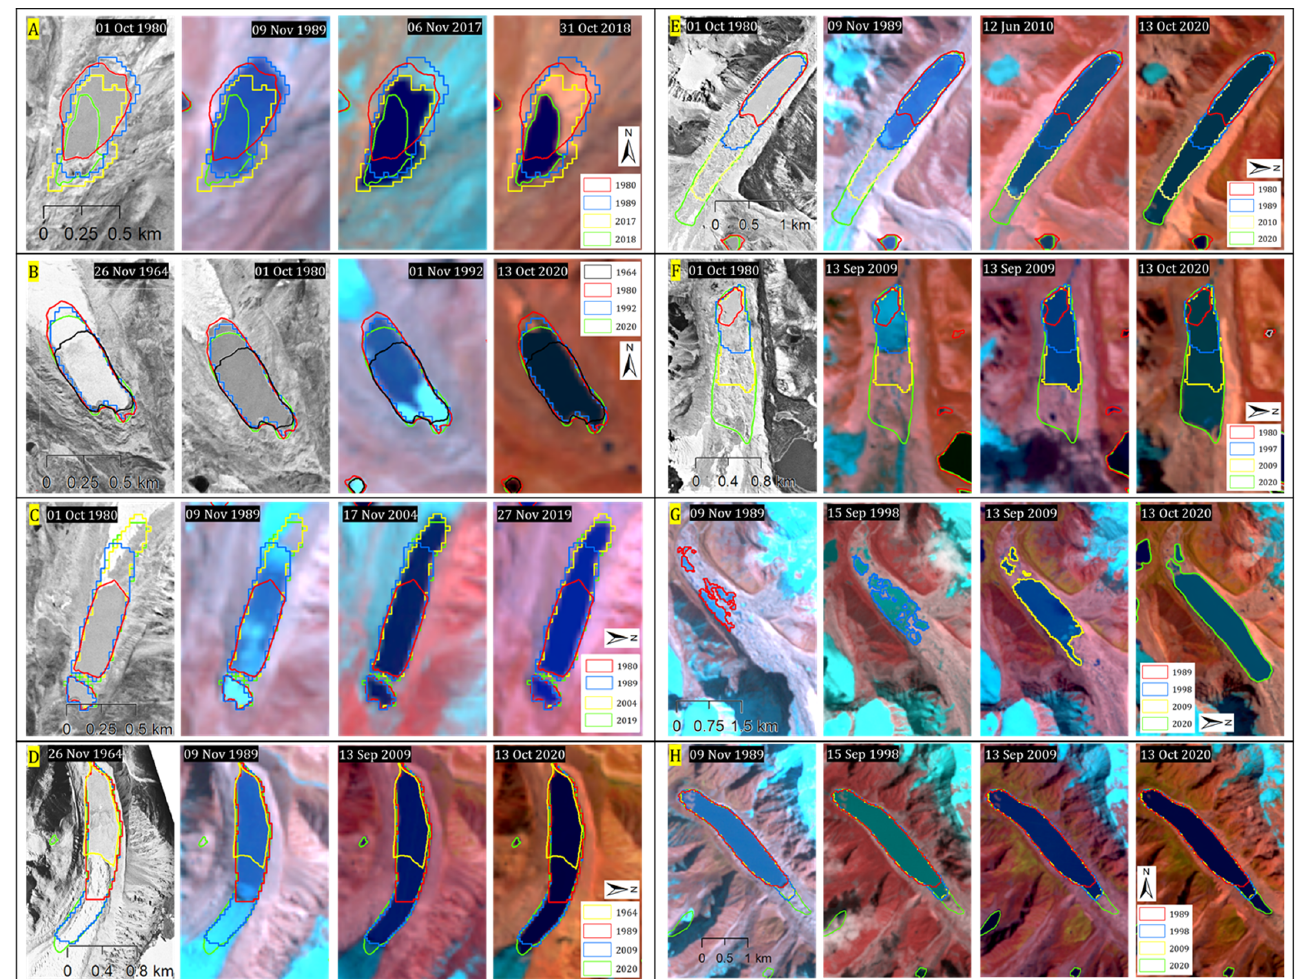
Figure 5. The expansion process of eight (Lake A – H ) rapidly expanding proglacial lakes with the background of KH and Landsat images.